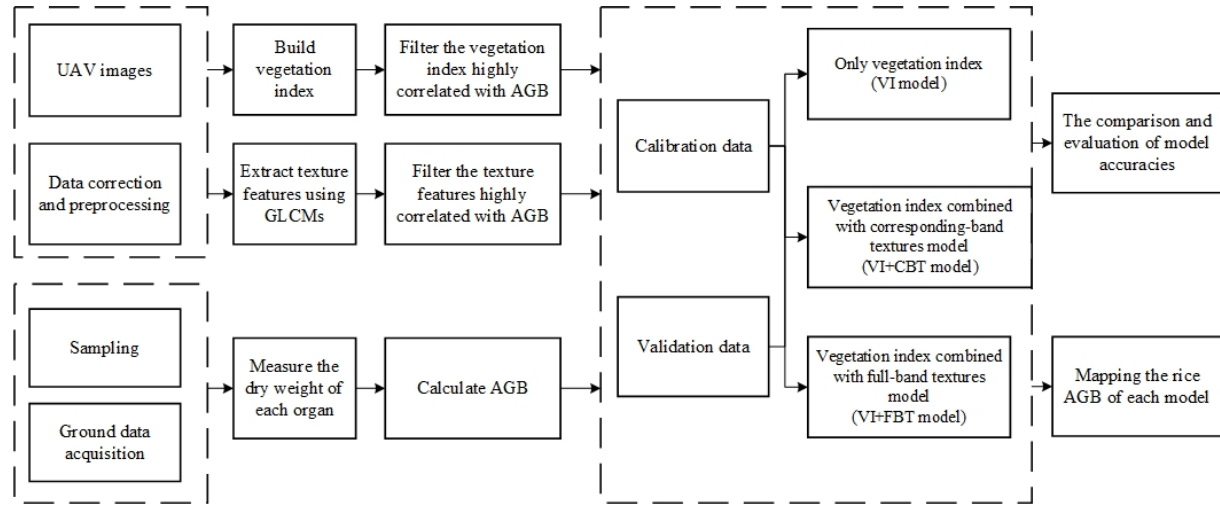
Figure 4. Research